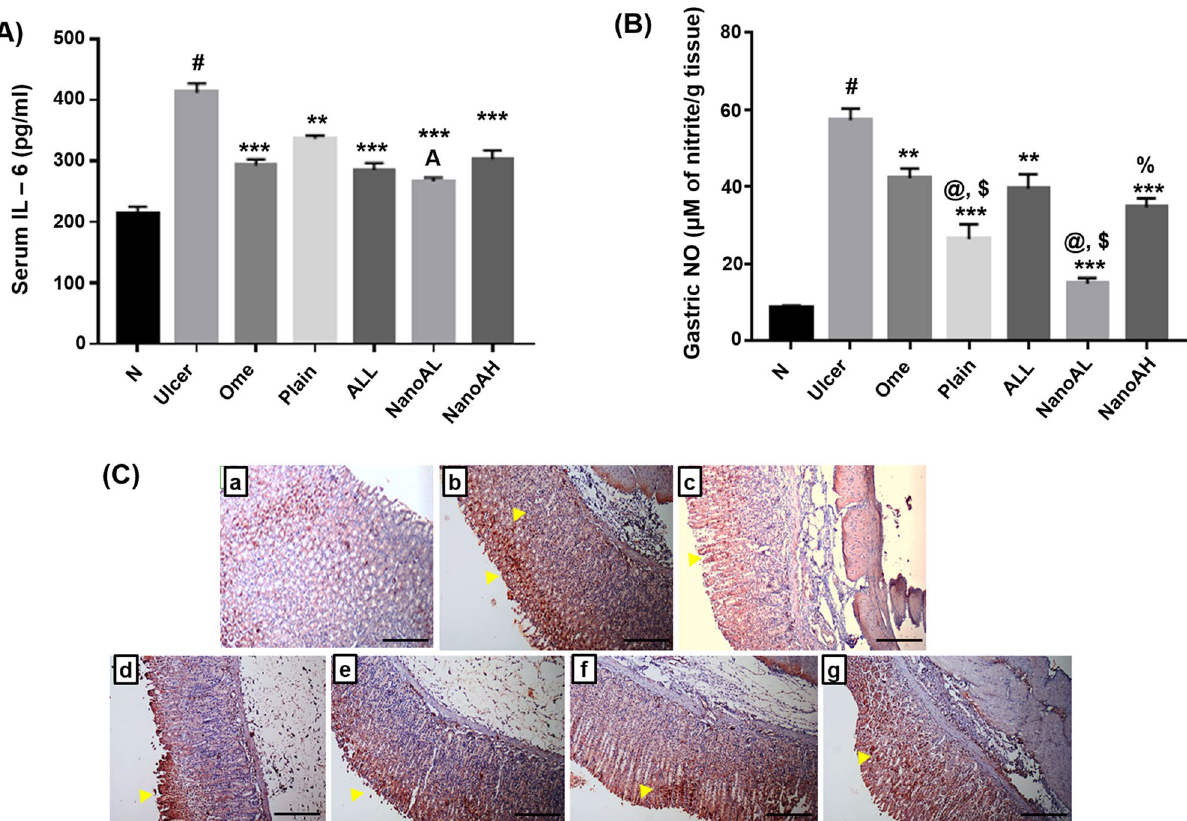
Figure 12. Levels of pro-inflammatory mediators; ( A ) serum level of IL-6 (pg/ml) and ( B ) gastric level of NO (μM of nitrite/g tissue). ( C ) Immunostaining of TNF-α in rats’ gastric tissues (X: 100). (a) N group, (b) ulcer group, (c) ome group, (d) plain group, (e) ALL group, (f) NanoAL group, and (g) NanoAH group. X: 100. Data are expressed as mean ± SEM, # p < 0.001 compared to N group, ** p < 0.01 compared to ulcer group *** p < 0.001 compared to ulcer group, @ p < 0.01 compared to Ome group, $ p < 0.001 compared to ALL group, A p < 0.01 compared to plain group, % p < 0.001 compared to NanoAL group using GraphPad Prism 5.00 (http://www.graph pad.com). Positive stainings are shown by yellow